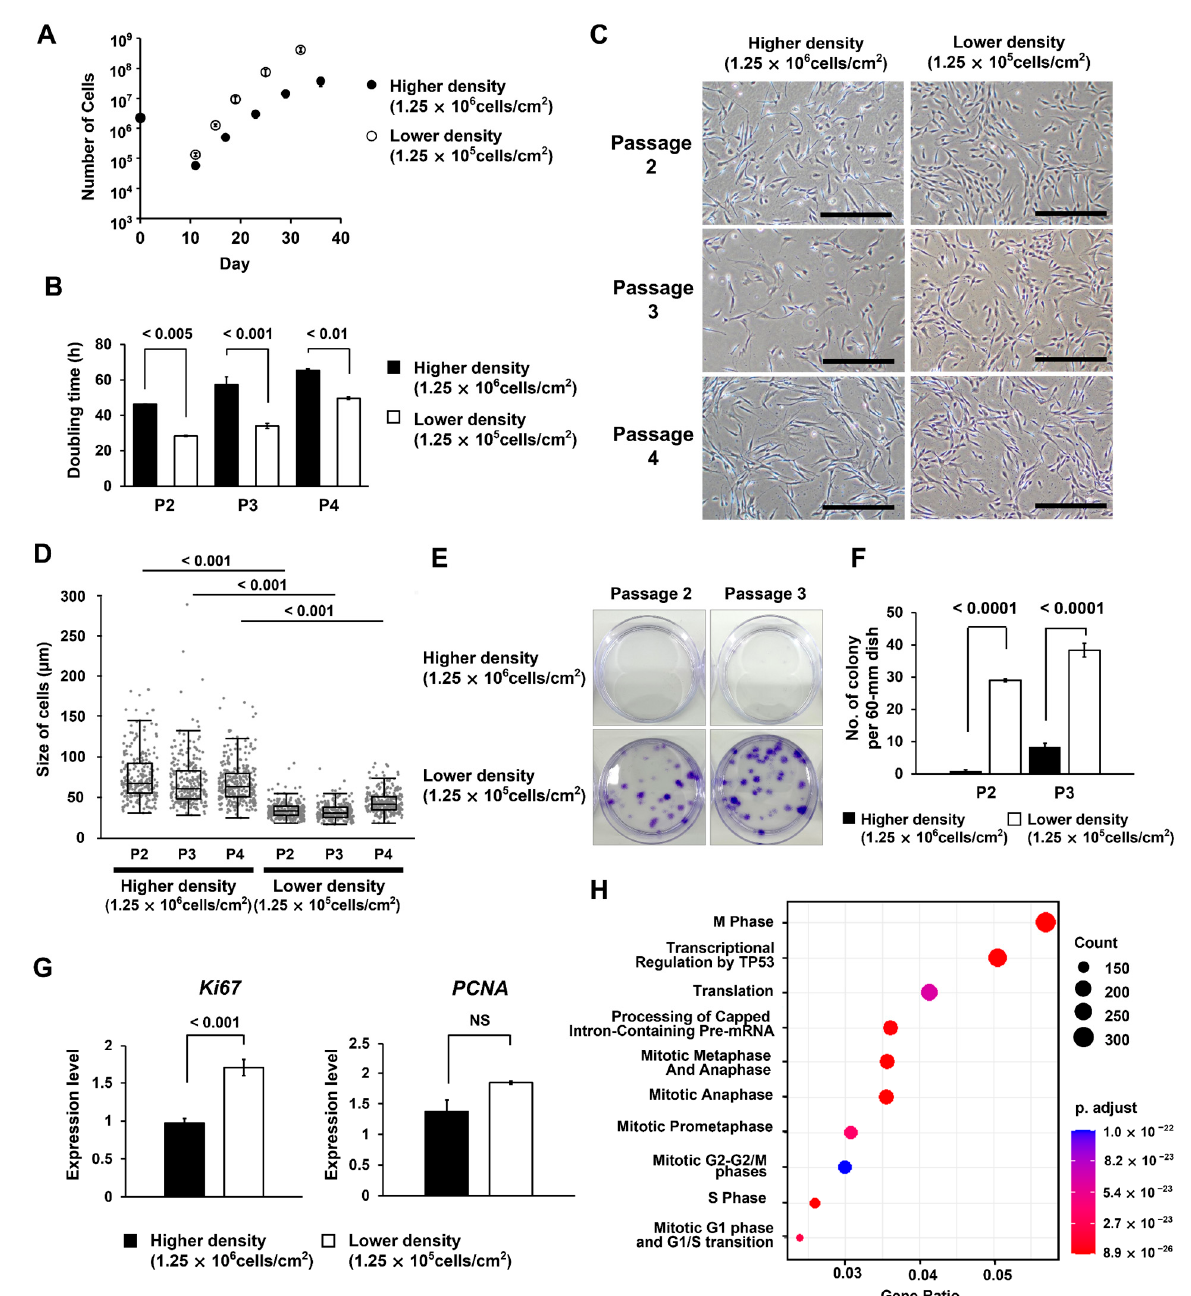
Figure 5. Characterization of mesenchymal stem cells (MSCs) isolated at higher (1.25 × 10 6 cells/cm 2 ) and lower (1.25 × 10 5 cells/cm 2 ) seeding densities of mononuclear cells (MNCs). ( A ) The number of cells harvested. The error bars indicate S.E. ( n = 3). ( B ) Doubling time of cells in each passage (Passage2–4). The error bars indicate S.E. ( n = 3). ( C ) Phase-contrast microscopy images of cells of each passage (Passage2–4). The scale bar indicates 500 µm. ( D ) Boxplot shows cell size data obtained using the microscopic images. ( E ) Colony-forming assay results. One hundred cells of passages 2 and 3 were seeded in 60 mm dishes. After being cultured for 14 d, colonies were stained with crystal violet. ( F ) Data quantifying the number of colonies formed in the colony assay. The error bars indicate S.E. ( n = 3). ( G ) Data from real-time PCR analysis of Ki67 and PCNA in Passage 2 cells. The error bars indicate S.E. ( n = 3). p -values were calculated using a Student’s t -test. NS indicates not significant. ( H ) SAGE analysis shows the function of genes specifically expressed in MSCs obtained under low density conditions.